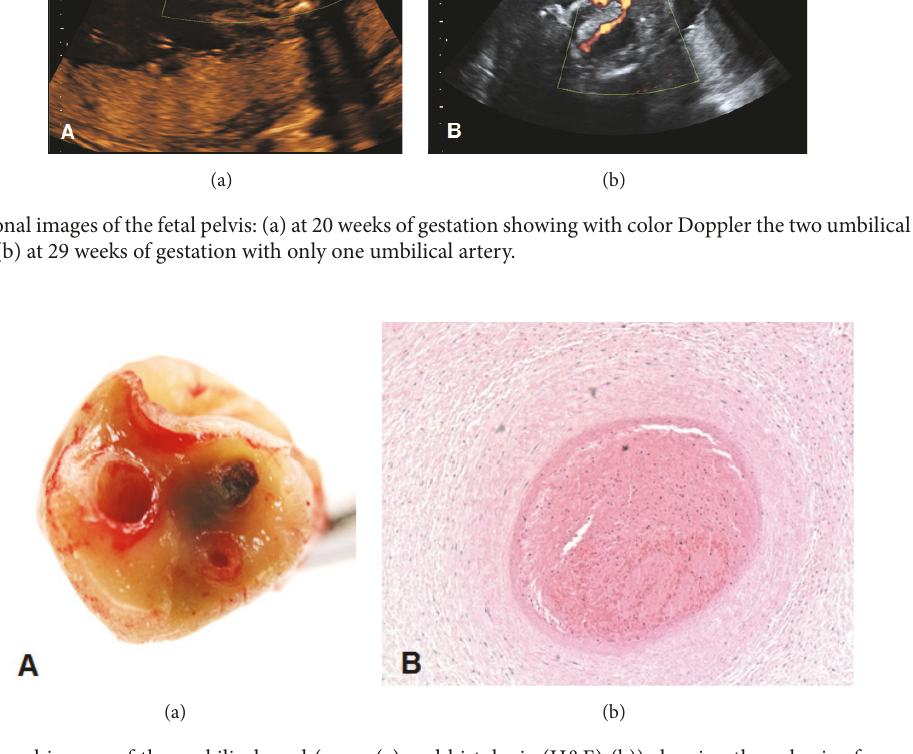
Figure 2: Cross-sectional images of the umbilical cord (gross (a) and histologic (H&E) (b)) showing thrombosis of one of the umbilical